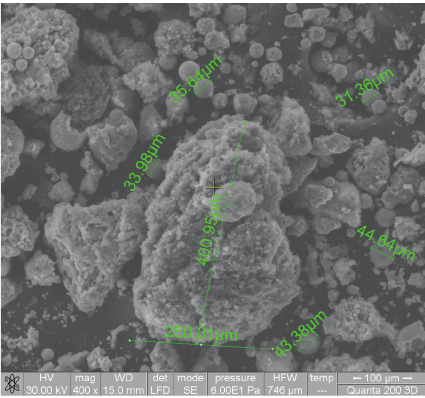
Figure 1: Scanning electron microscopic image of the coal fly ash from the Holboca Thermal Power Plant (magnified 400x).